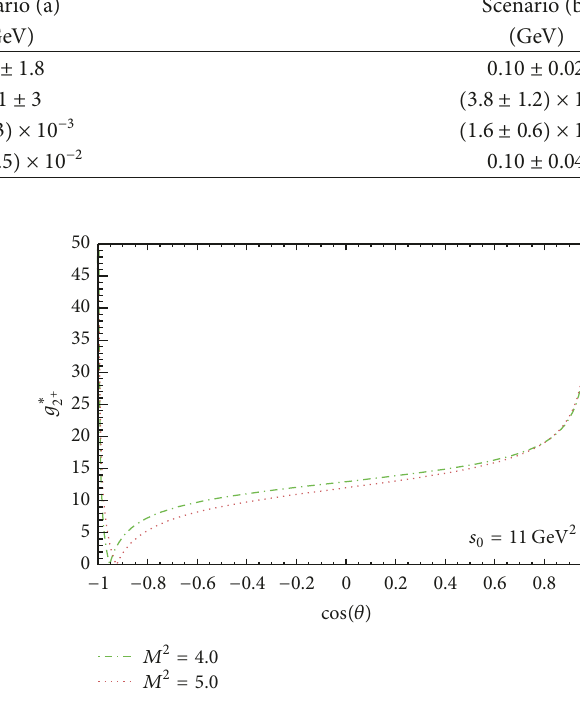
Figure 7: Same as in Figure 5, but for scenario (b). Figure 8: Same as in Figure 6, but for scenario